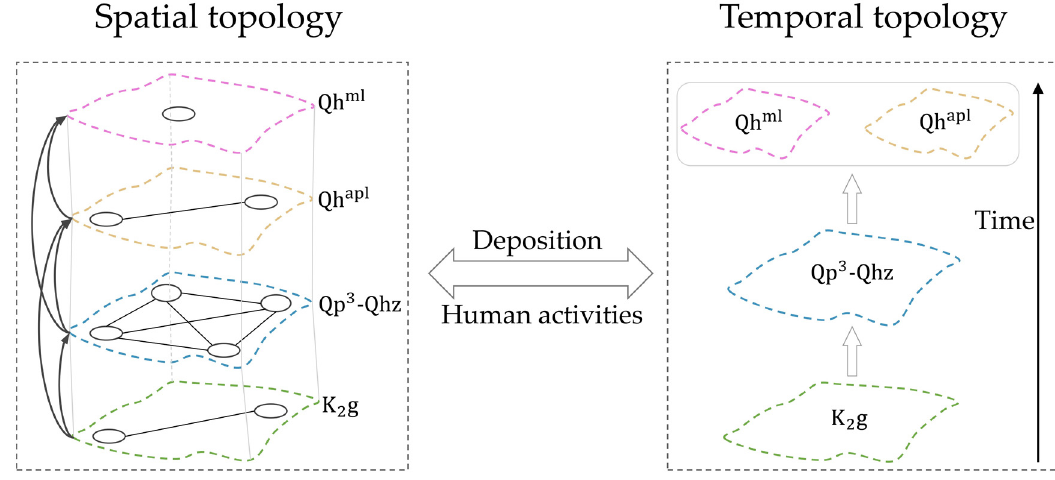
Figure 10. The geological topology of the 3D geological model.